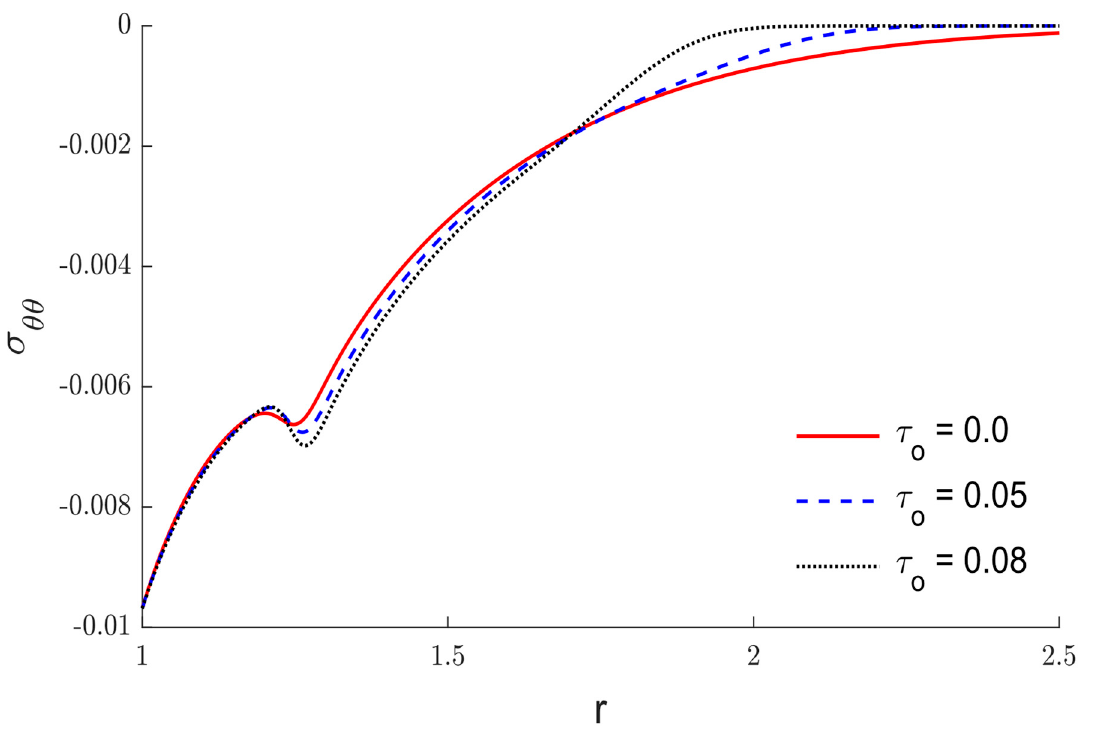
Figure 9. The impacts of thermal relaxation time τ o in the variation of shear stress σ θθ , when K n = −0.6 .